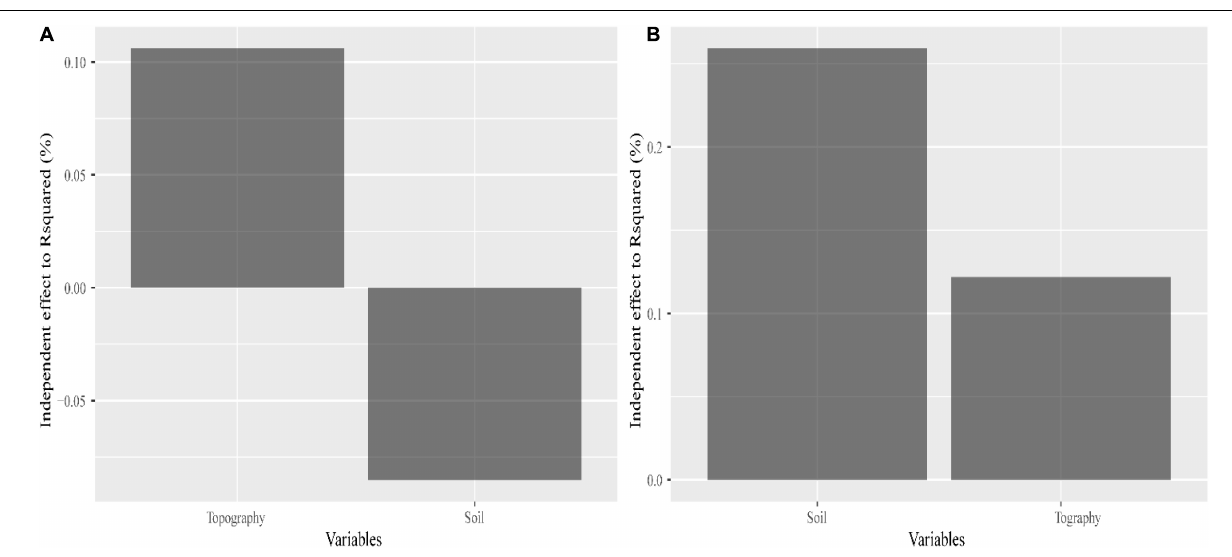
Frontiers in Plant Science |